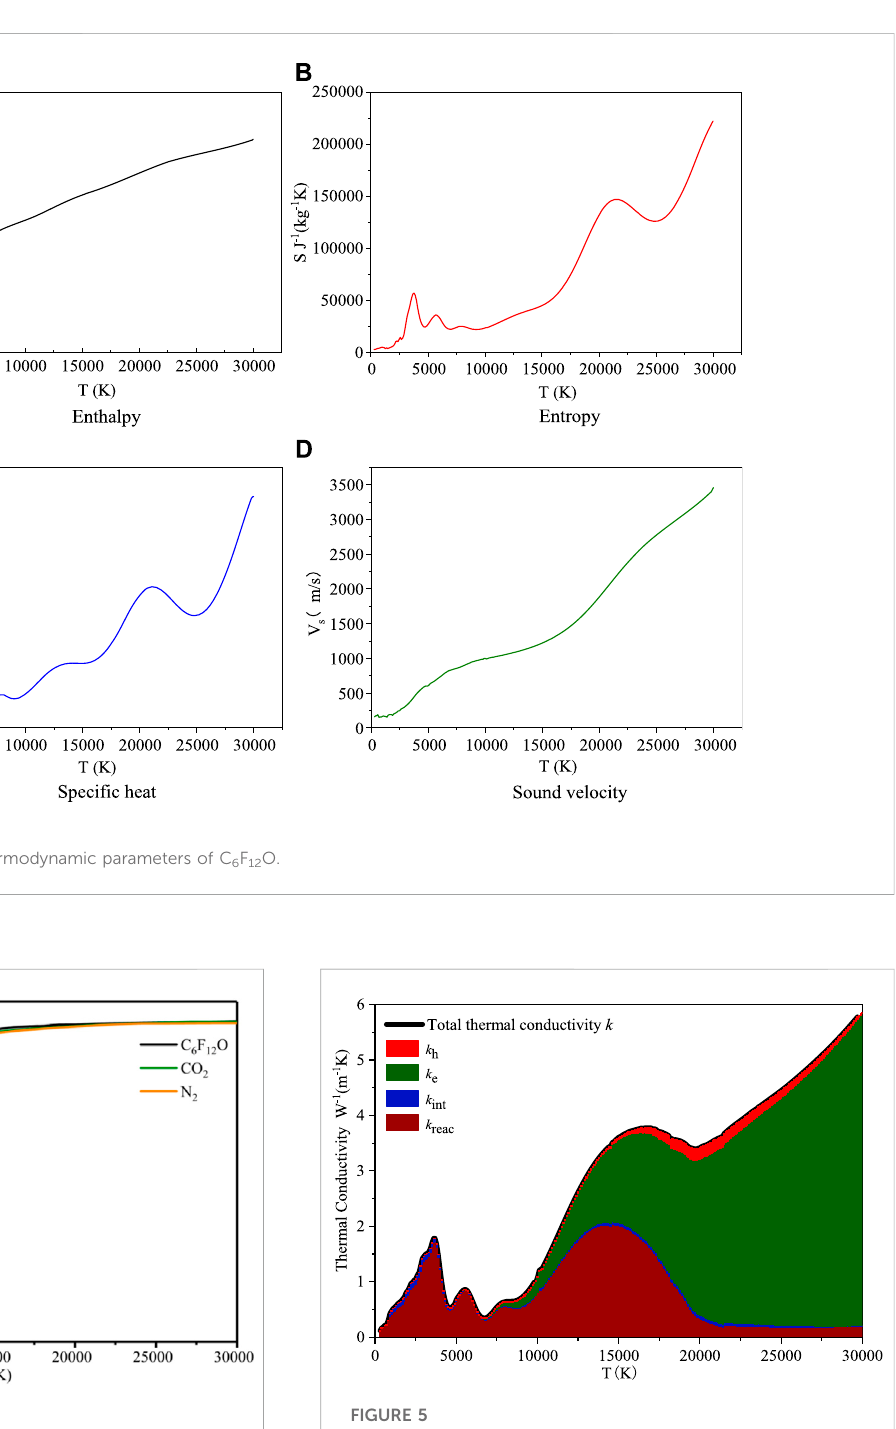
FIGURE 4 Conductivity of C 6 F 12 O, CO 2 and N 2 .